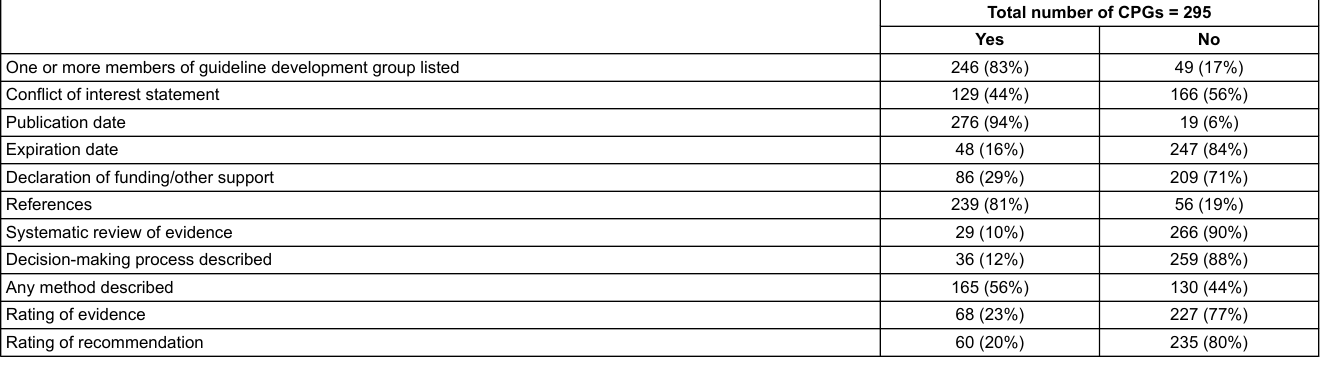
Table 2: Quality and transparency